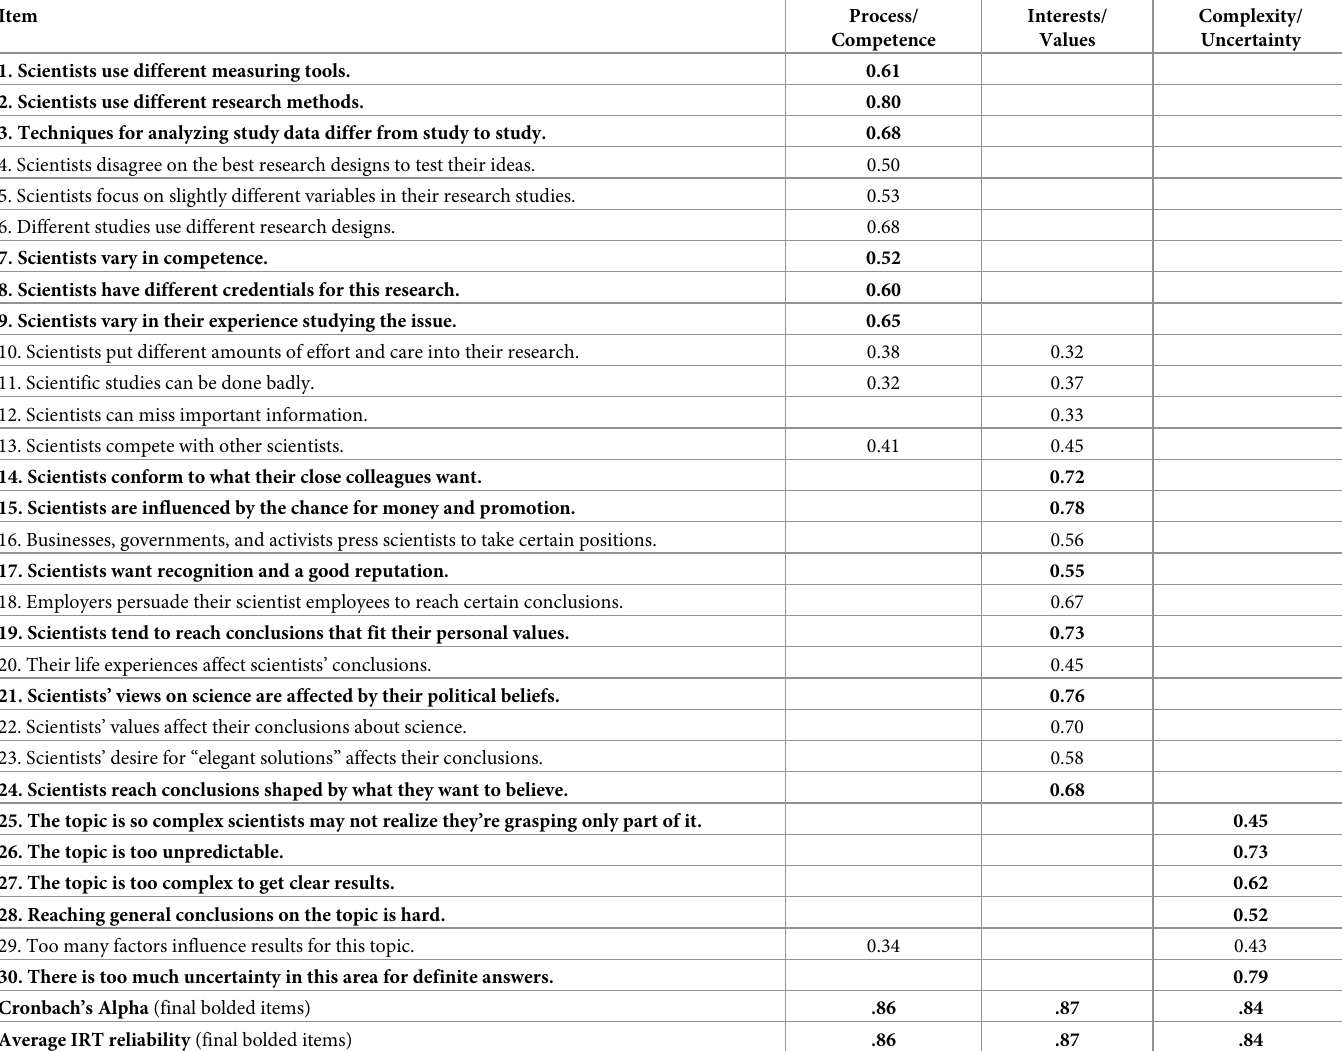
Table 1. Study 1. Reasons for science disputes principal axis factoring